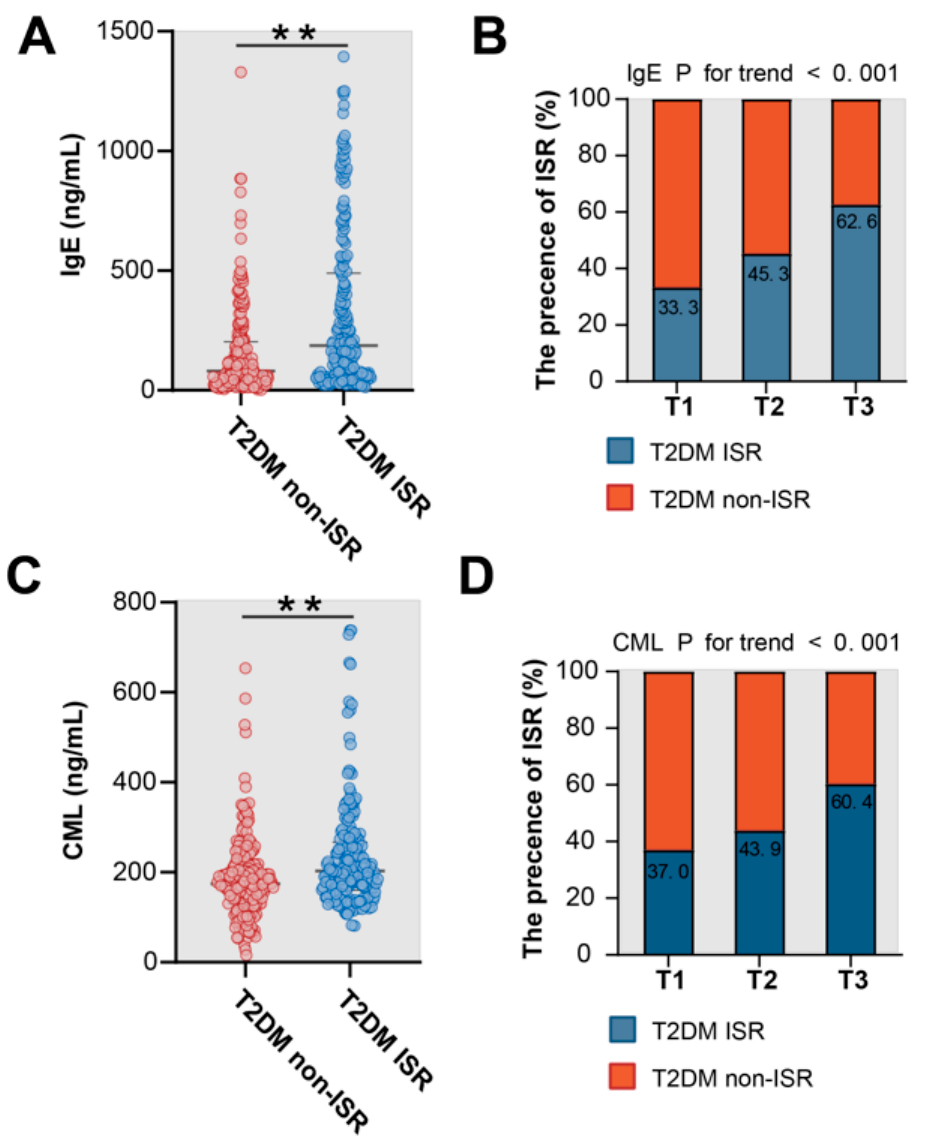
Figure 2. Association of serum IgE and CML levels with ISR in T2DM patients. Comparison of serum IgE ( A ) and CML ( C ) levels between patients with and without ISR in T2DM patients. In-stent restenosis across the tertiles of IgE ( B ) and CML ( D ). ISR: in-stent restenosis; T2DM: type 2 diabetes mellitus. ** p < 0.01. red dots: individuals with T2DM non-ISR, blue dots: individuals with T2DM ISR. Table 2. Correlation between CML and IgE in patients with T2DM.